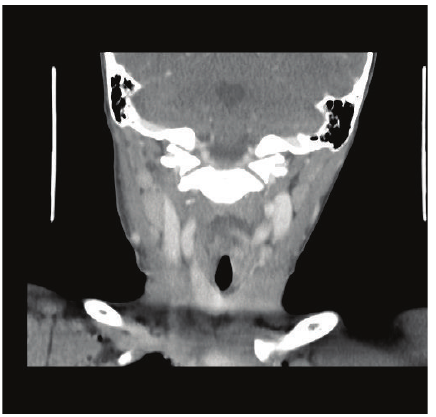
Figure 3: Magnetic resonance venogram showing compression of the upper part of the right internal jugular